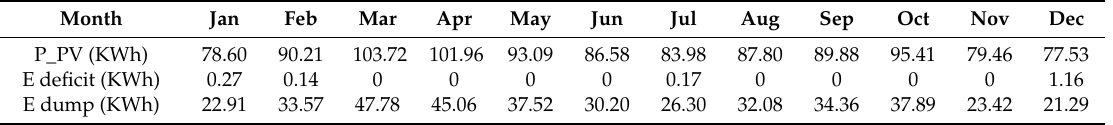
Table 7. shows monthly average daily performance of the SAPV system under optimal